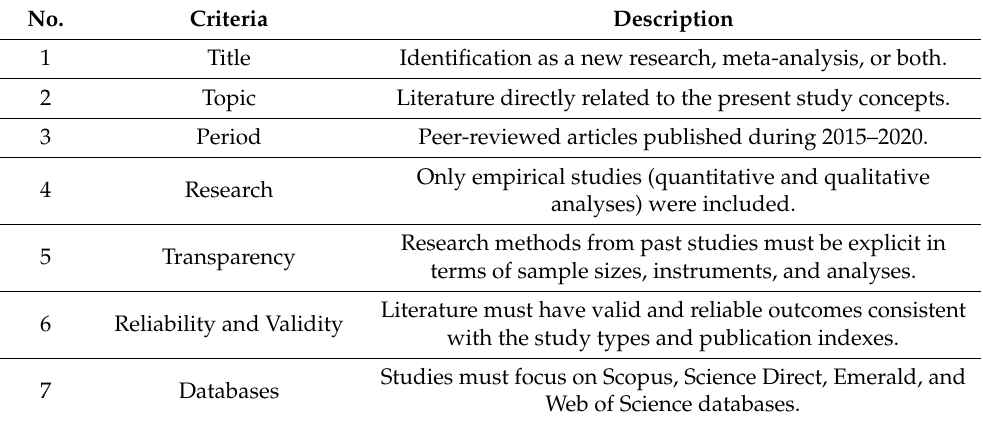
Table 1. Inclusion criteria for literature review adapted from (Ali et al.